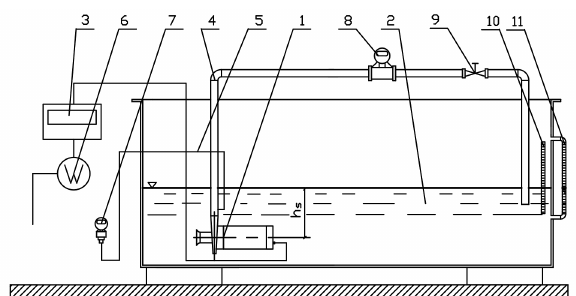
Figure 3: Computational model: a) geometry ; b) mesh was shown. The flow curve for both research methods is stable, the head is decreasing while raising the flow. It is possible to notice the difference in the shape between the curves of the flow characteristic. The experimental curve has higher steepness then obtained from CFD modeling. As a reason for this situation could be the small